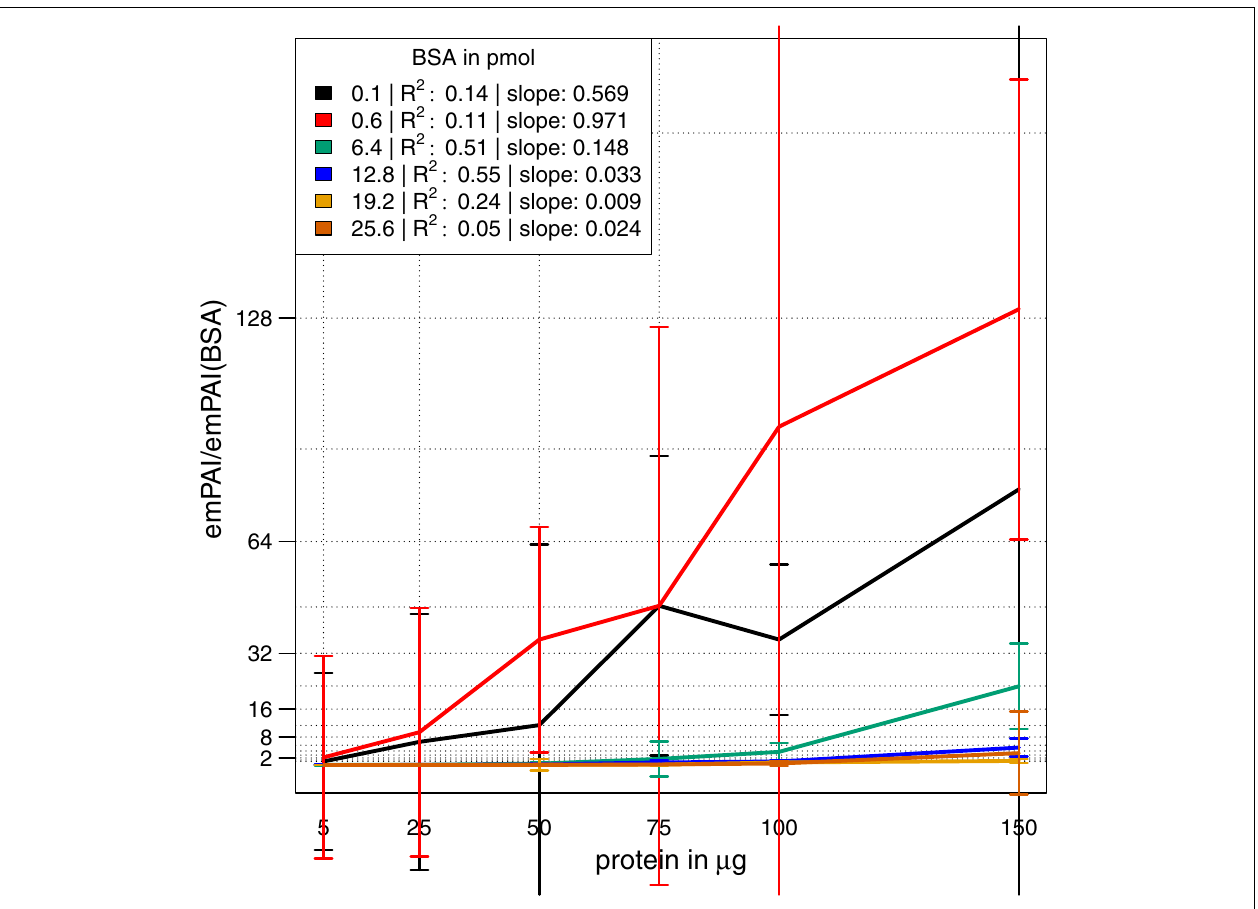
FIGUREA2 |The use of RPN in quantitation based on spectral counting . emPAI values of reference protein BSA and the sample proteins were used as quantitative readout. In general, standard deviations were higher compared to RPN based on peptide ion intensity